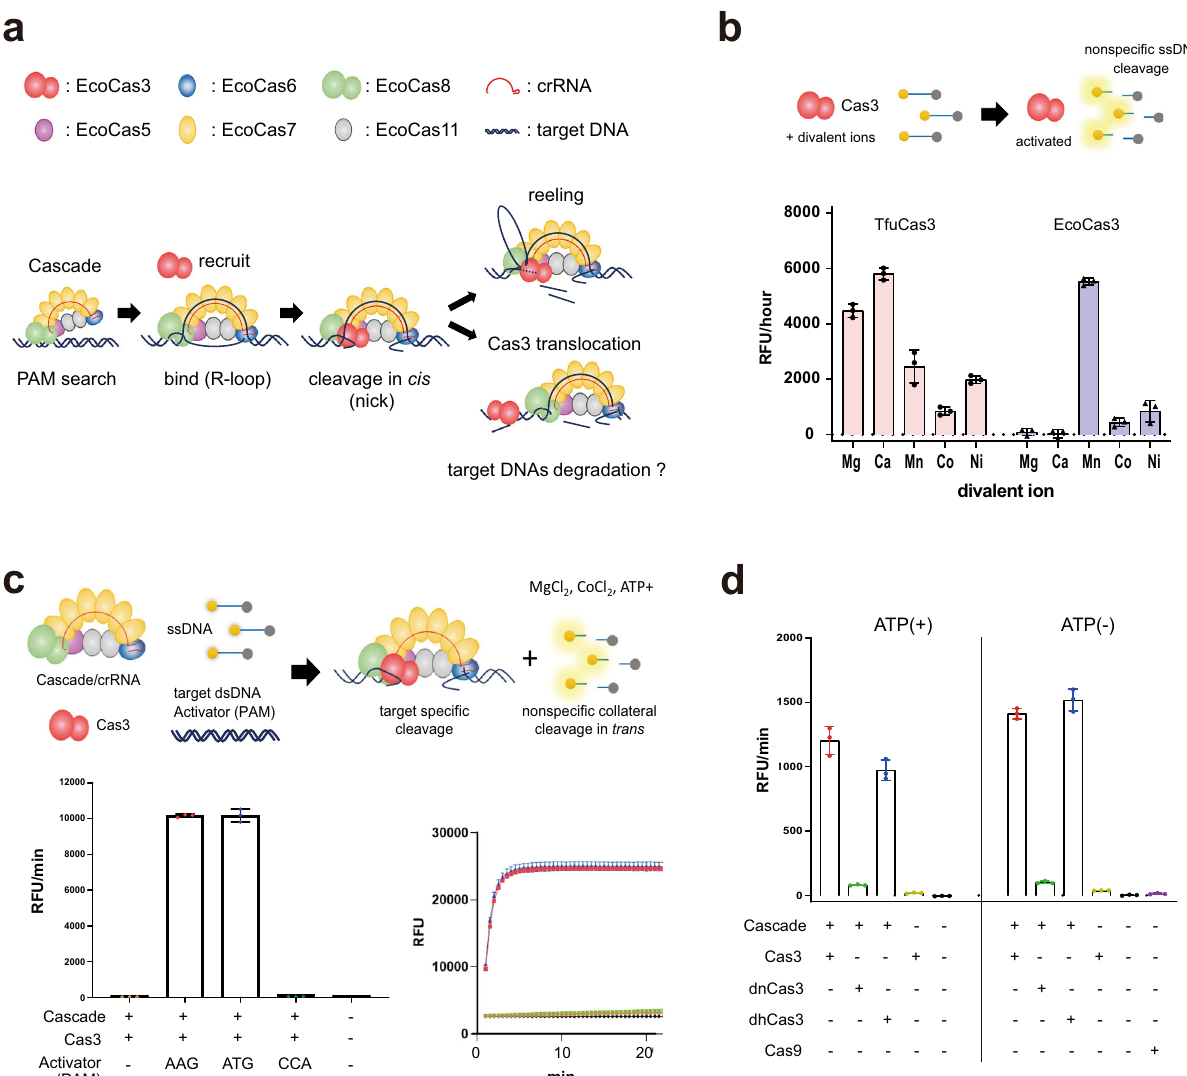
Fig. 1 | In vitro reconstituted EcoCas3-EcoCascade/crRNA complex cleaves nonspeci fi c ssDNA in trans. a Schematic depiction of the known type I CRISPR interferencemechanism. b , c Electrophoretic mobility shift assay(EMSA) and DNA degradation assay. b Activation of EcoCas3 and TfuCas3 by divalent metal ions (Mg 2+ , Ca 2+ , Mn 2+ , Co 2+ , and Ni 2+ ). Fluorescent dye-quencher (FQ)-labeled